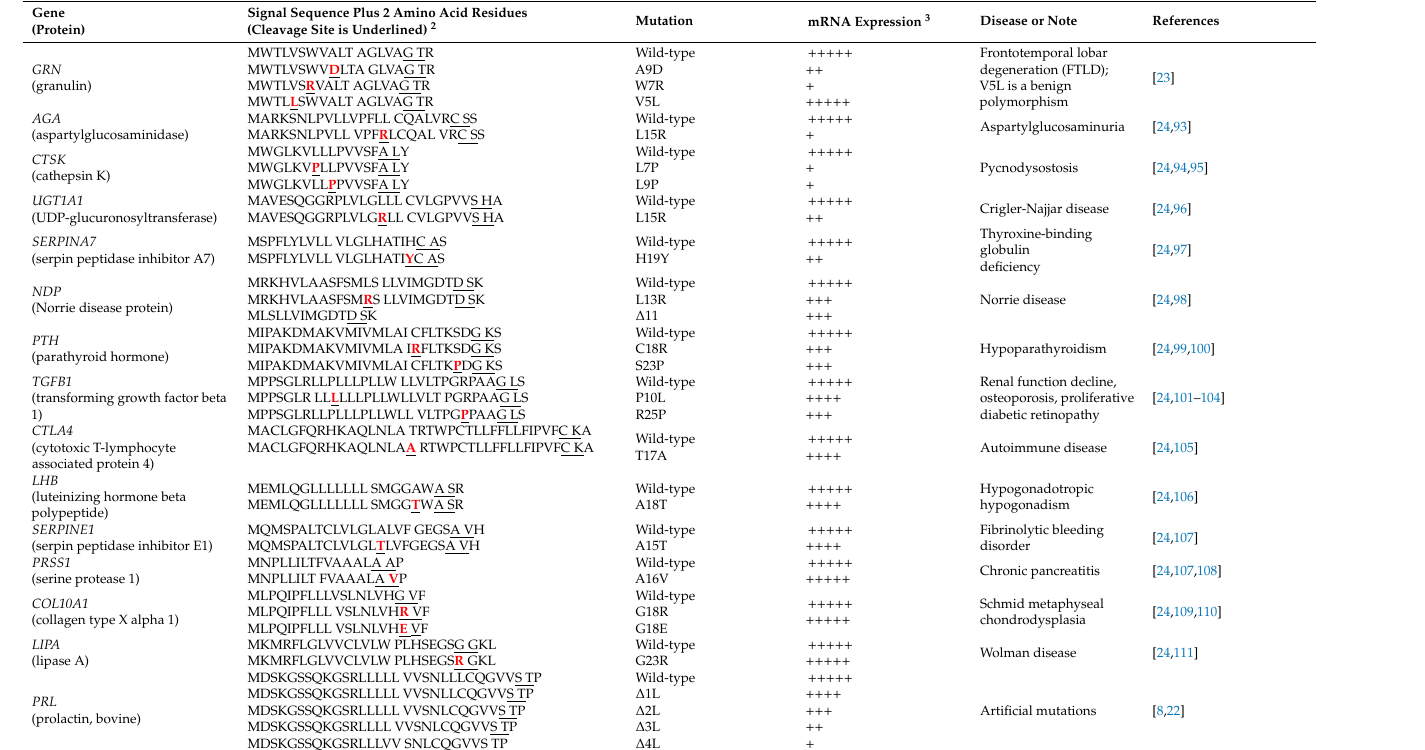
Table 2. Human diseases associated with mutations in signal peptides of secretory proteins 1